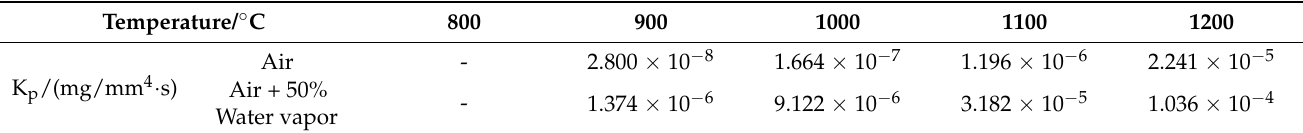
Table 5. K p values of Fe–10Cr steel in air and 50% water